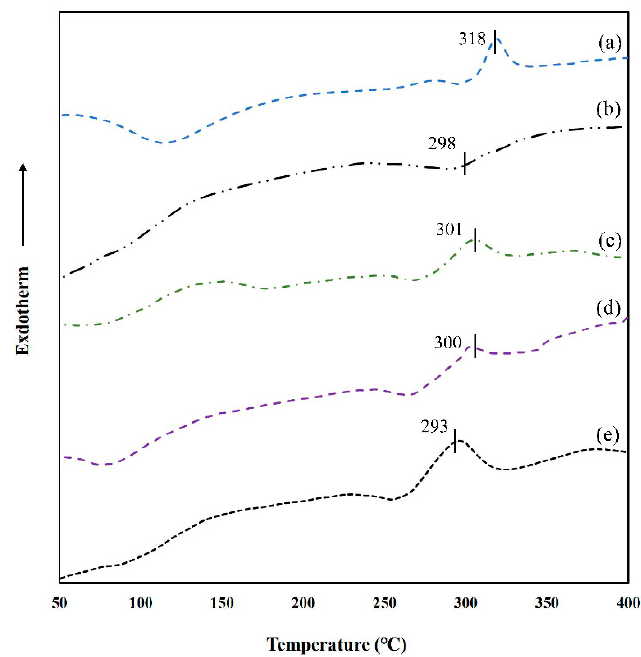
Figure 7. DSC thermograms of: GG powder (a); neat GG (b); and of GG fibrous mats loaded with: 10% TA (c); 15% TA (d); and 20% TA (e).